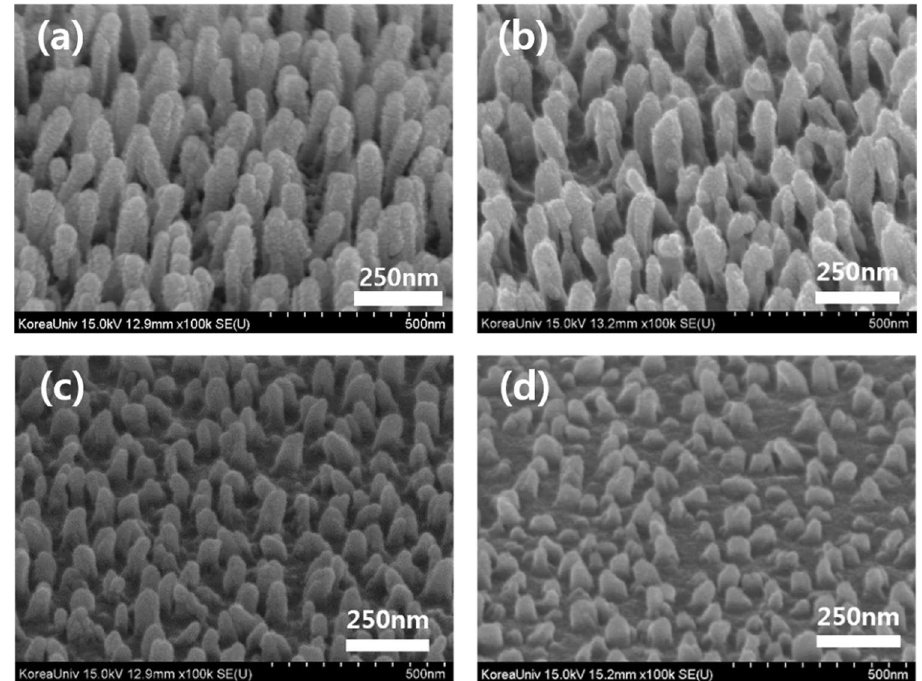
Figure 1. FE-SEM images of the fabricated nano-sized structures of the PMMA layer by varying the speed of the spin coater at ( a ) 1500, ( b ) 1750, ( c ) 2000, and ( d ) 2500 rpm.